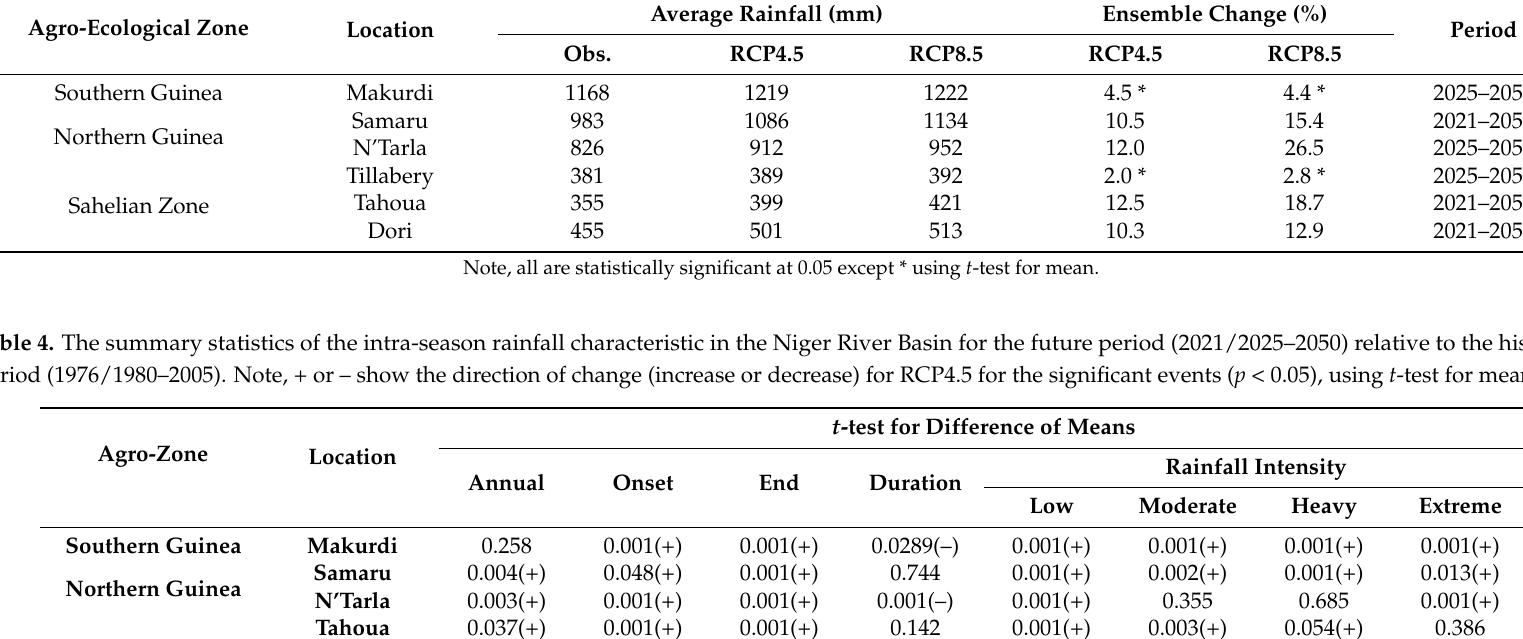
Table 3. Change in the seasonal rainfall for the Niger River Basin for the future period (2021/2025–2050) relative to the historical period (1976/1980–2005).